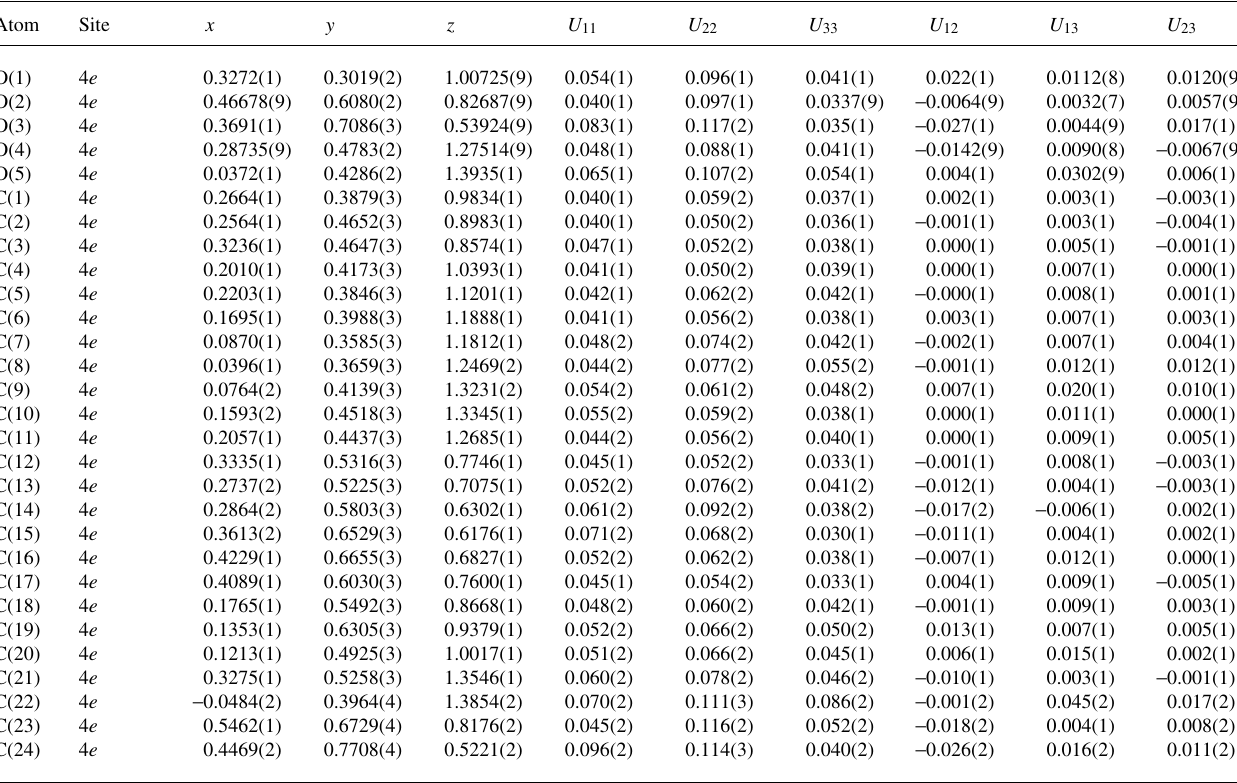
Table 3. Atomic coordinates and displacement parameters (in Å 2 ) .